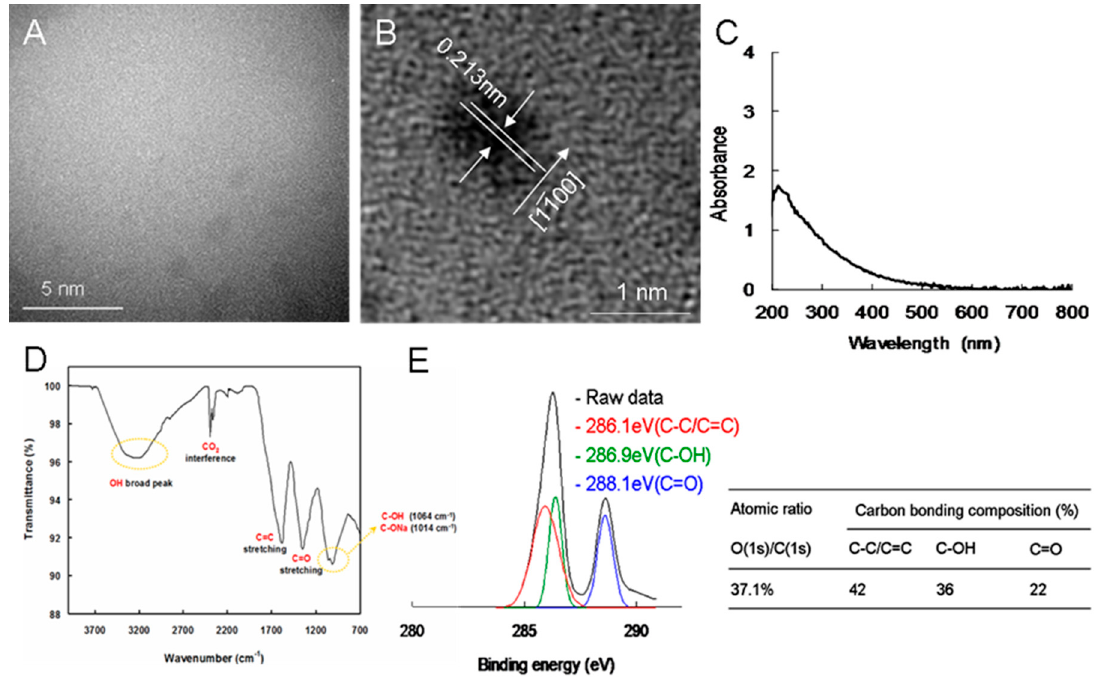
Figure 3. Functional characterization of the synthesized fullerenol. ( A ) Low-magnification TEM image shows the mean lateral size of a water-soluble fullerenol to be approximately 1.08 ± 0.03 nm ( B ) HR-TEM image of a water-soluble fullerenol illustrating the nanomaterials {1100} lattice planes and the mean size of 1.08 ± 0.03 nm with a d -spacing of 0.213 nm (inset: low-magnification TEM image of nanomaterials). ( C ) UV–Vis and ( D ) FTIR spectra of fullerenol. ( E ) Deconvoluted C(1s) X-ray photoelectron spectrometry (XPS) spectra and fitted peaks obtained using Gaussian function: nonoxygenated ring (C–C / C = C, 286.1 eV), C–OH bond (286.9 eV), and C–O − bond (288.1 eV), respectively. The atomic ratio and bonding composition of fullerenol are shown as summarized in the table. The O(1s) / C(1s) atomic ratio is 37.1%.